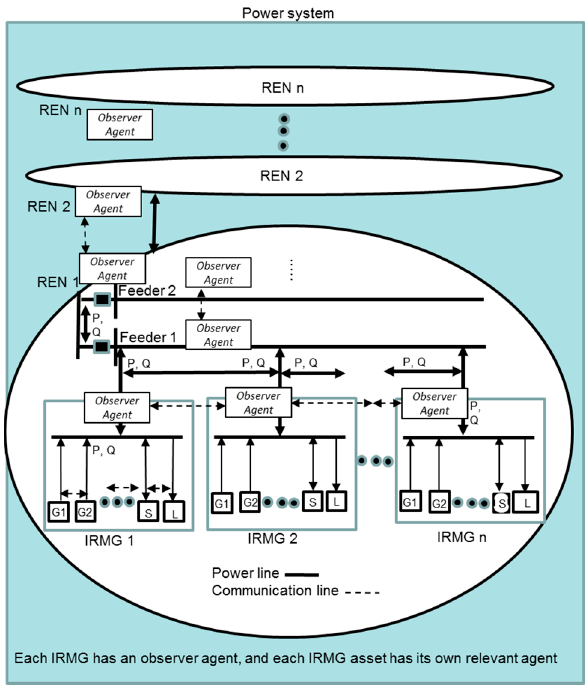
Figure 21. Agent communication and P, Q exchange at different levels of the hierarchy.